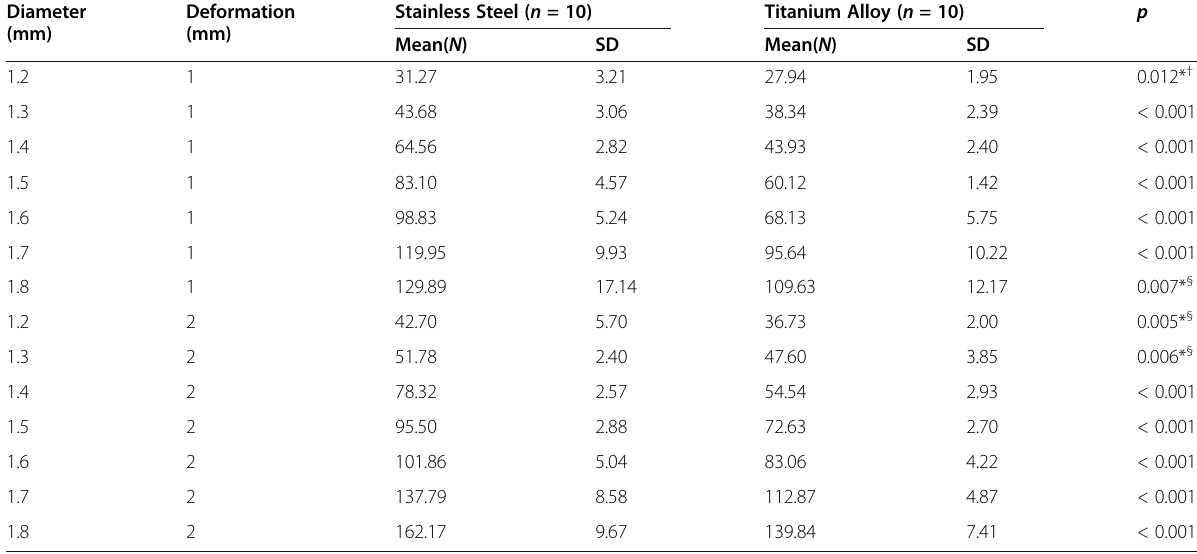
Table 3 Comparison of flexural force between SS-MIs ( n = 140) and TA-MIs ( n = 140) Diameter